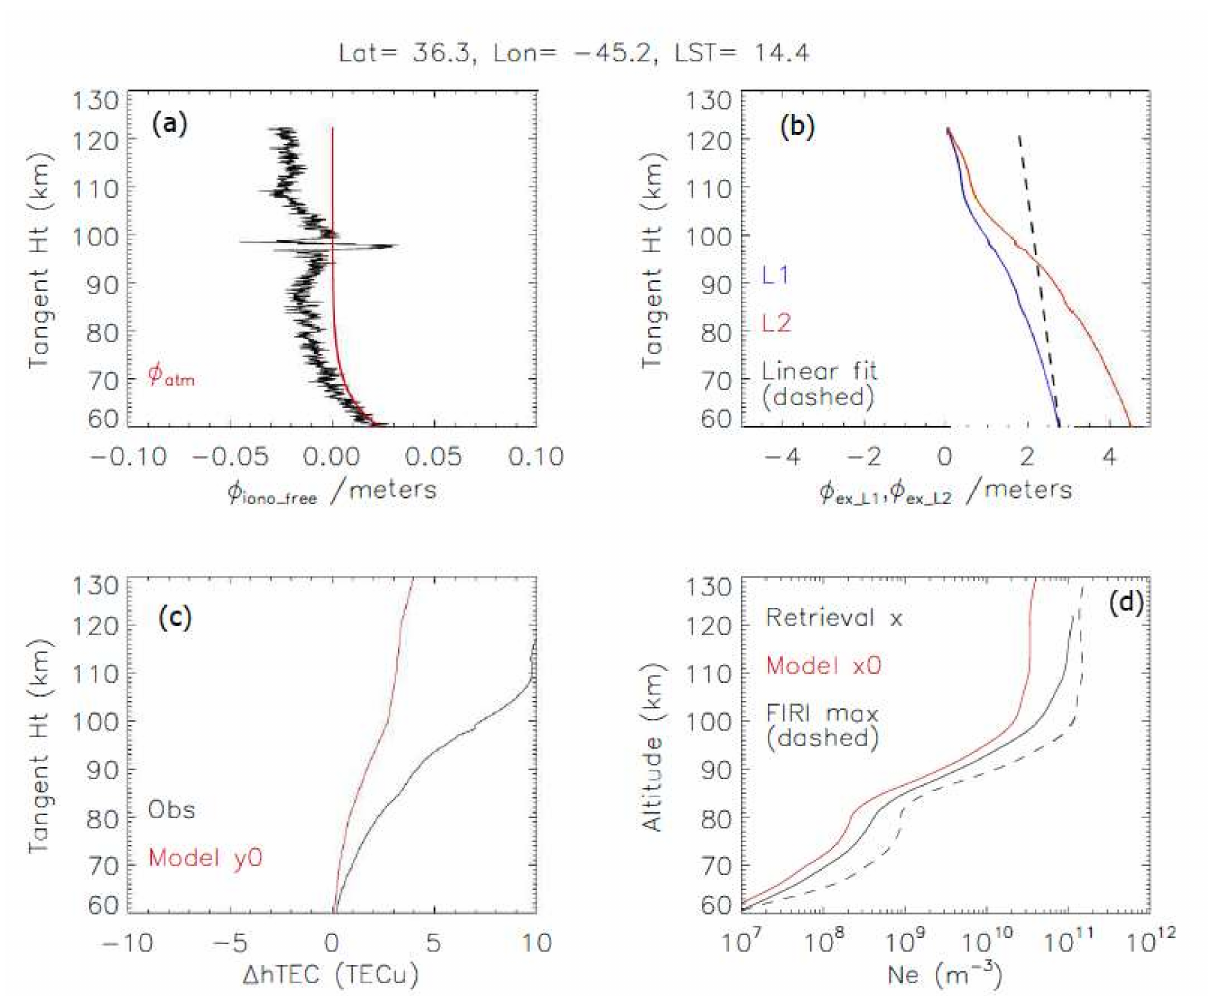
Figure 4. ( a – d ) Illustration of a COSMIC-1 RO N e profile retrieved from 1 January 2008. Differences between the ∆ hTEC measurement profile and the linearized model y state vector x for N e